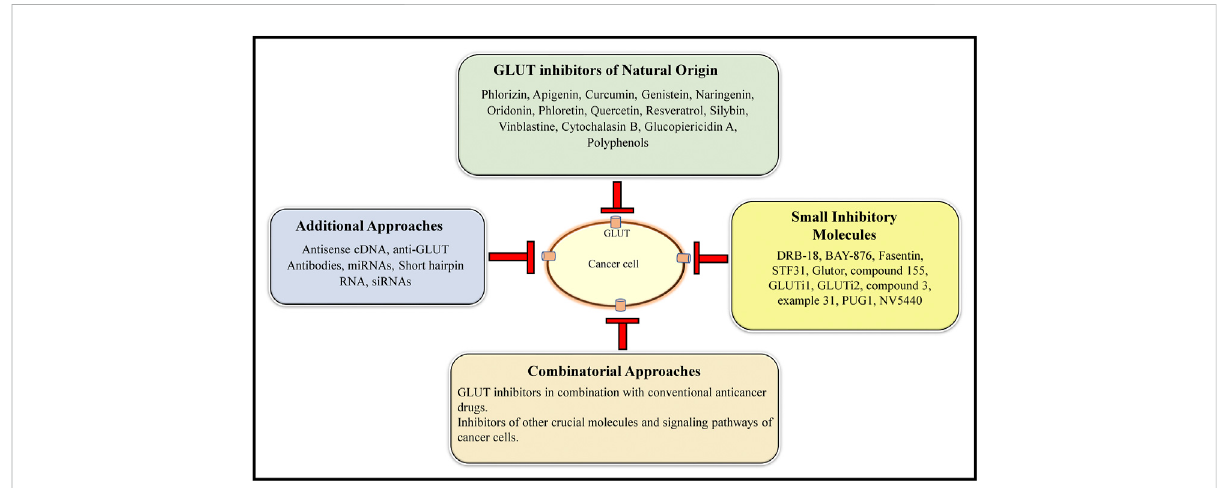
FIGURE 6 A collation of the current GLUT inhibitory approaches. The main GLUT inhibitors belong to both natural and small inhibitory molecule categories. In addition, antisense cDNA, anti-GLUT antibodies, miRNAs, shRNA, and siRNAs constitute additional GLUT inhibitory approaches. GLUT inhibition can be further potentiated by combining the GLUT inhibitors of natural origin and small inhibitory molecule